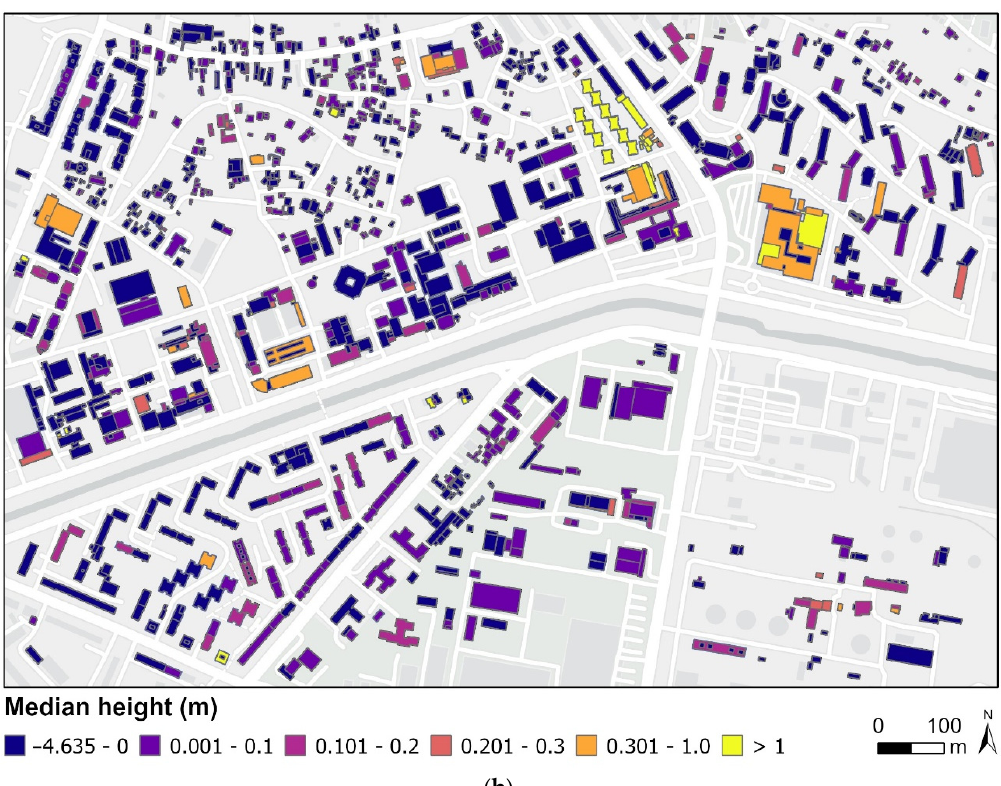
Figure 24. Map of building height residuals calculated by mean method ( a ) and median method ( b ).